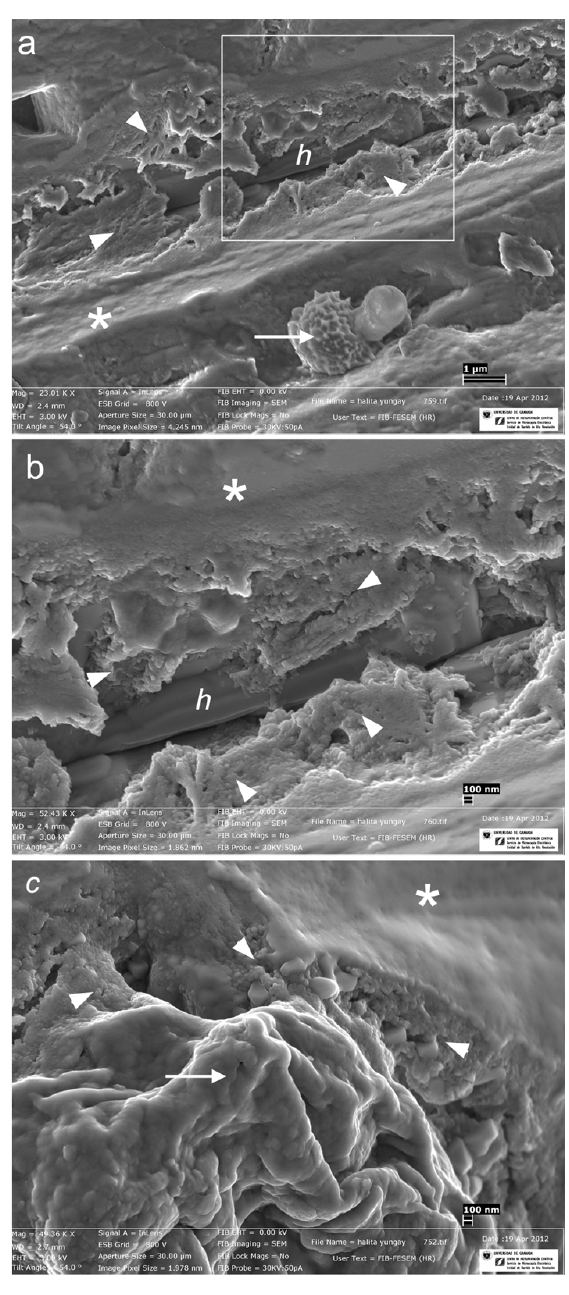
Fig. 6. HR-SEM images of desiccated halite. (a) General view of halite crystal ( h) covered by a nano-porous phase (white arrow- heads) containing pores < 100nm; arrows point to microorganism cell. (b) Detailed HR-SEM image from square area in (a) of nano- porous phase (white arrowheads). (c) Microbial aggregate (arrow) in close contact with nano-porous phase (white arrowheads). Note that asterisks in all images show smooth skin surface coating the nano-porous